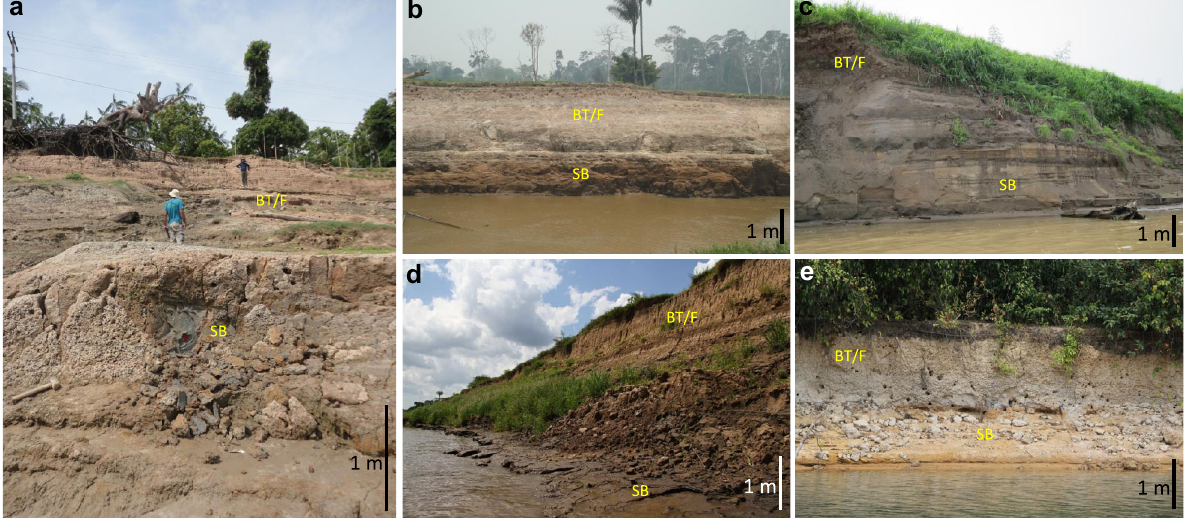
Fig. 4 | Sedimentary deposits forming the substrates of seasonally fl ooded environments in lowland Amazonia. The general sedimentary architecture is represented by underlying sandybar (SD) depositscovered by muddy bartop and fl oodplain (BT/F) deposits. Pictures were taken during the dry season (September to November). Sedimentary facies are shown in Fig. 6. a Right margin of the Soli- mões River, upstream the Tefé River mouth near sampling site ALC29. b Left